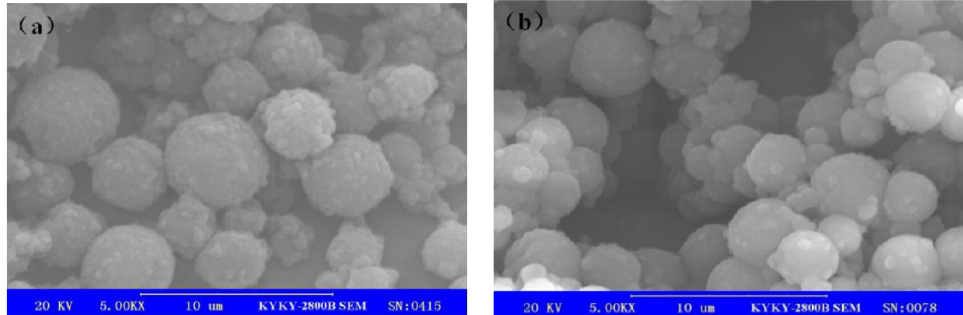
Figure 8. SEM morphology of the prepared MicroPCMs at the emulsification stirring speed of ( a ) 5000 rpm and ( b ) 6000 rpm.